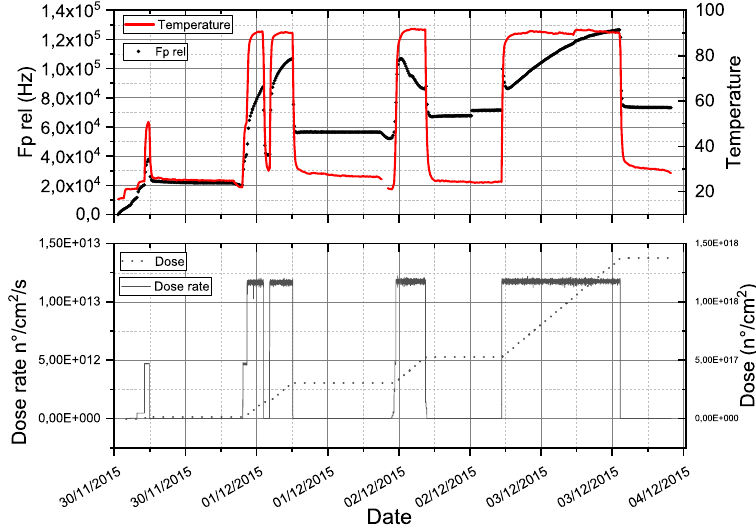
Fig. 8 : example of experimental results obtained during 5